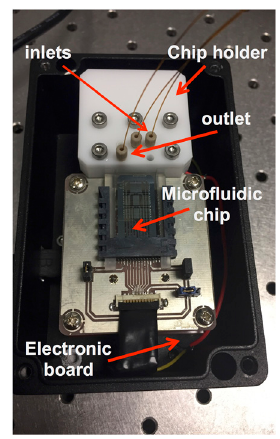
Figure 6. Picture of a horseradish peroxidase (HRP) functionalized chip connected to the electronic board for H 2 O 2 detection.